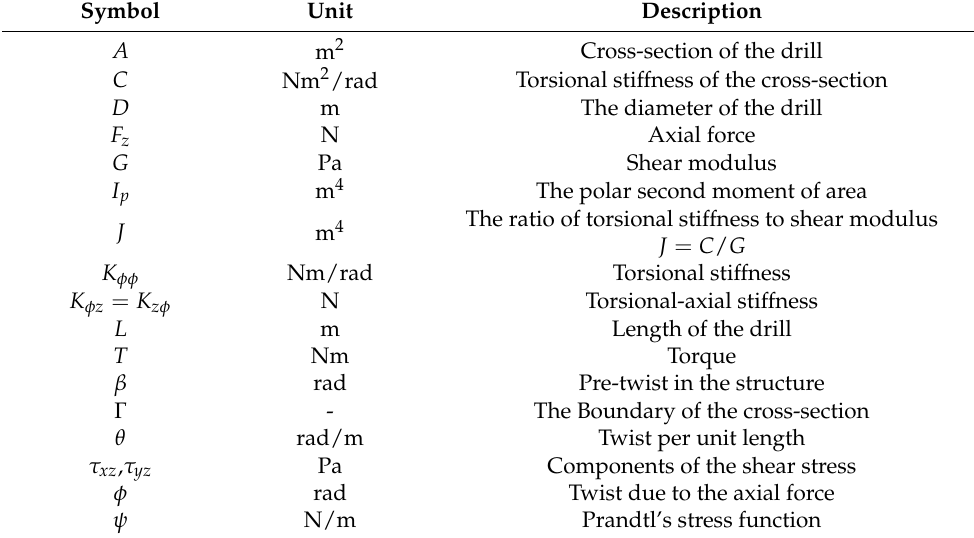
Table 1. Nomenclature.